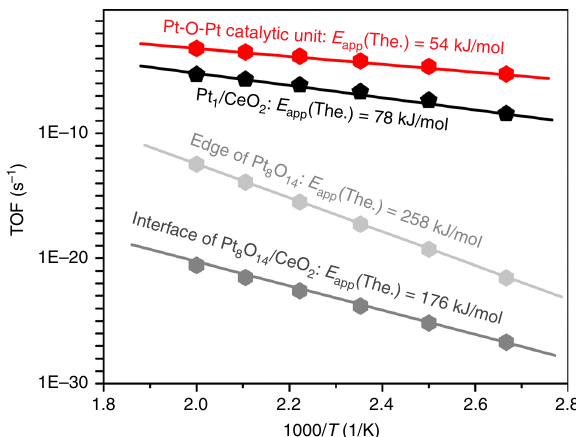
Fig. 4 Microkinetic simulations for various CO oxidation routes on the Pt 1 / CeO 2 and Pt 8 O 14 /CeO 2 structures. The predicted apparent activation barriers, E app (The., theory predicted),